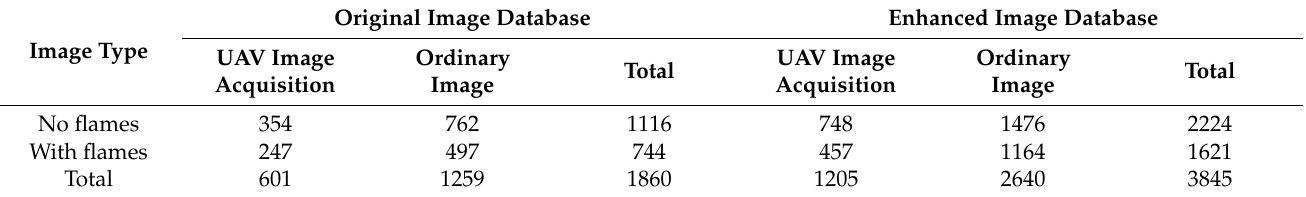
Table 3. The image databases.